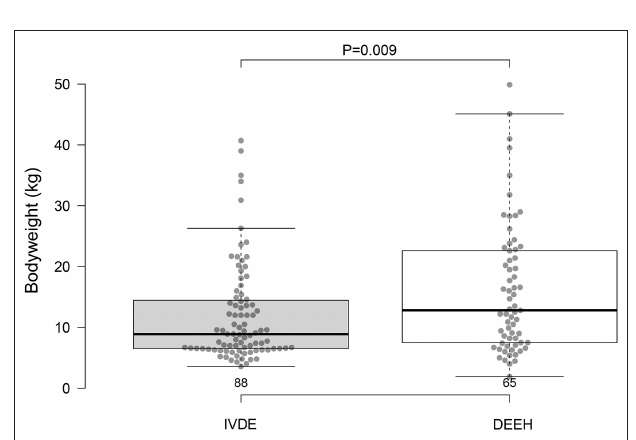
FIGURE 5 | Modified Frankel Score (MFS) at the time of admission for cases with IVDE and DEEH.